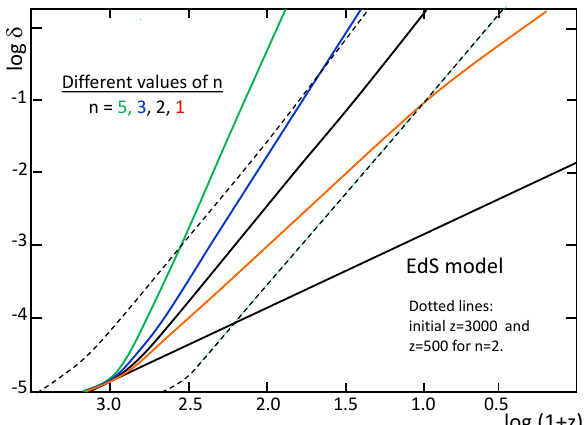
Figure 3. The growth of density fluctuations for different values of parameter n (the gradient of the density distribution in the nascent cluster), for an initial value δ = 10 − 5 at z = 1376 and Ω m = 0.10. The initial slopes are those of the EdS models. The two light broken curves show models with initial ( z + 1 ) = 3000 and 500, with same Ω m = 0.10 and n = 2. These dashed lines are to be compared to the black continuous line of the n = 2 model. All the three lines for n = 2 are very similar and nearly parallel. Due to to the smallness of δ the application of the log function results in negative numbers; thus, the corresponding vertical axes values are all